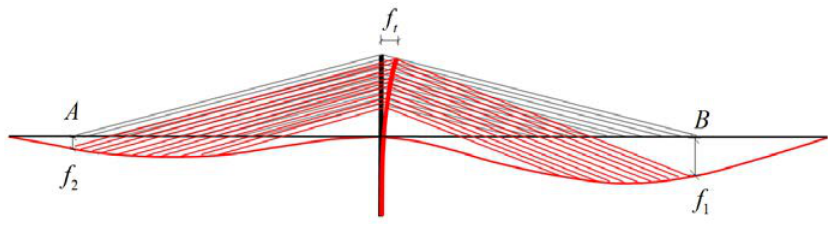
Figure 7. Deformation of the structure.